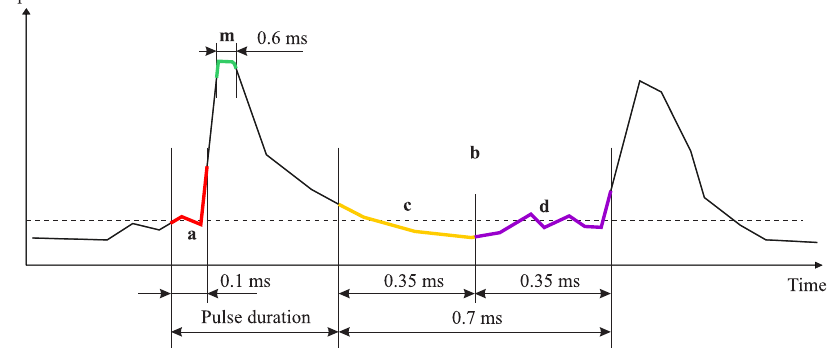
Figure 8. Example of threshold value adaptation to background noise level.